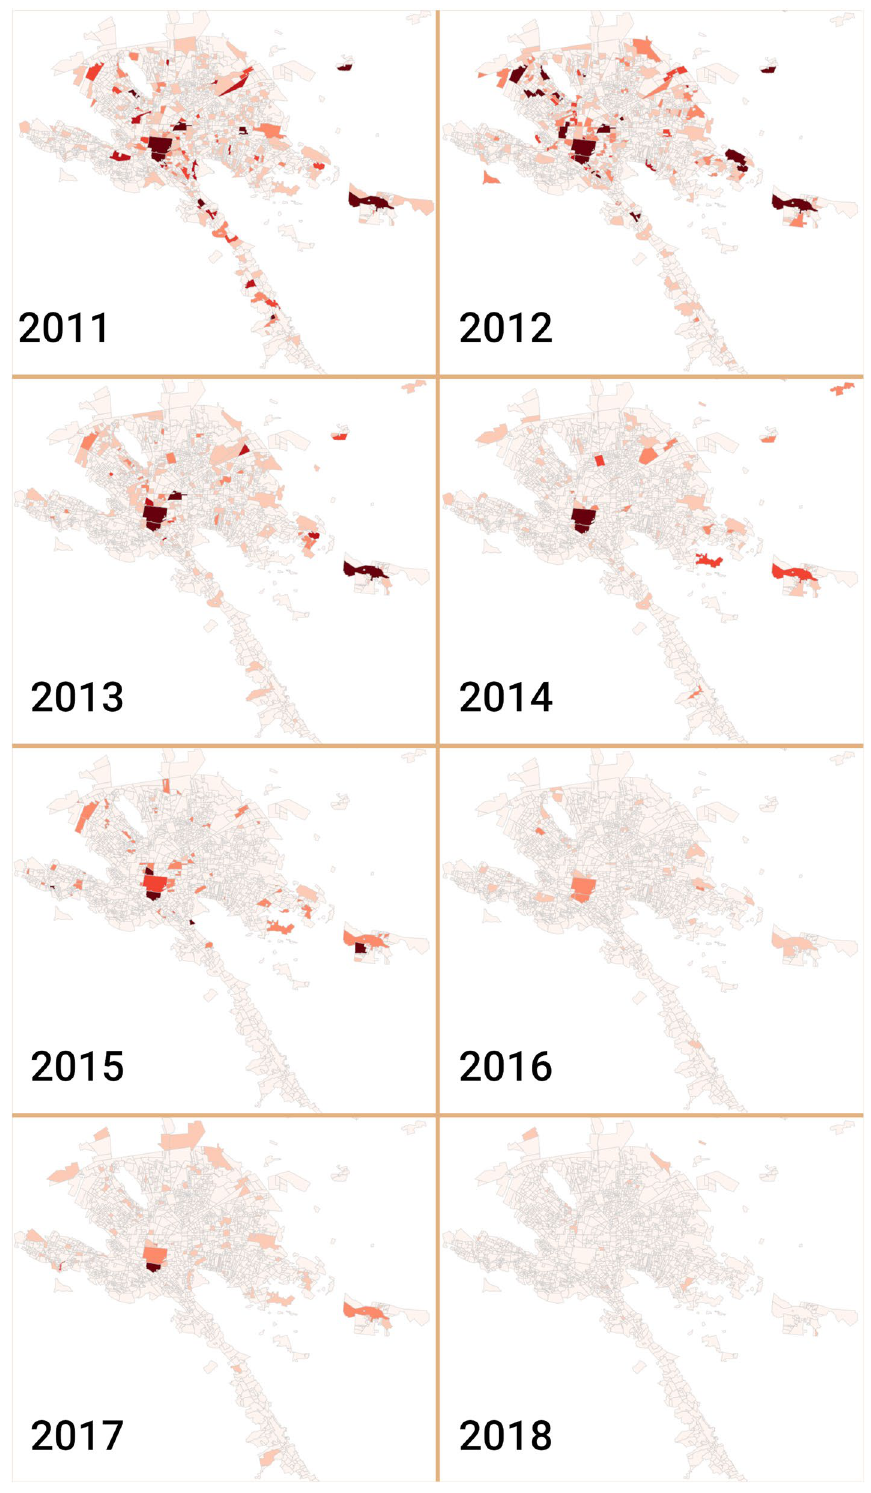
Figure 5. Geospatial yearly distribution of homicides in MMA. In these maps, neighborhoods are depicted according to the number of homicides that took place there. Light colors represent lower number of casualties, meanwhile dark colors take account for higher homicide